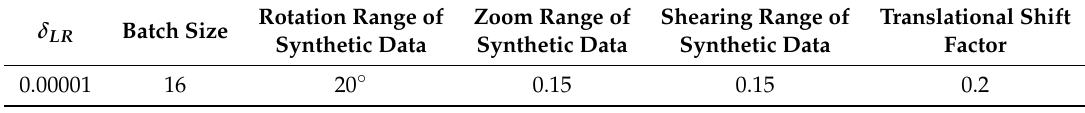
Table 1. Hyper-parameters setting of the regressor